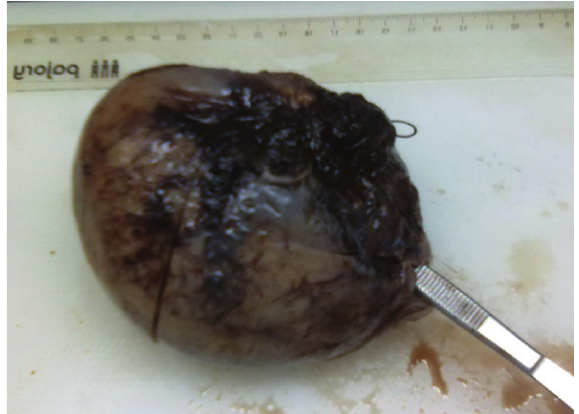
Figure 1: Rudimentary uterine horn after delivery and excision.